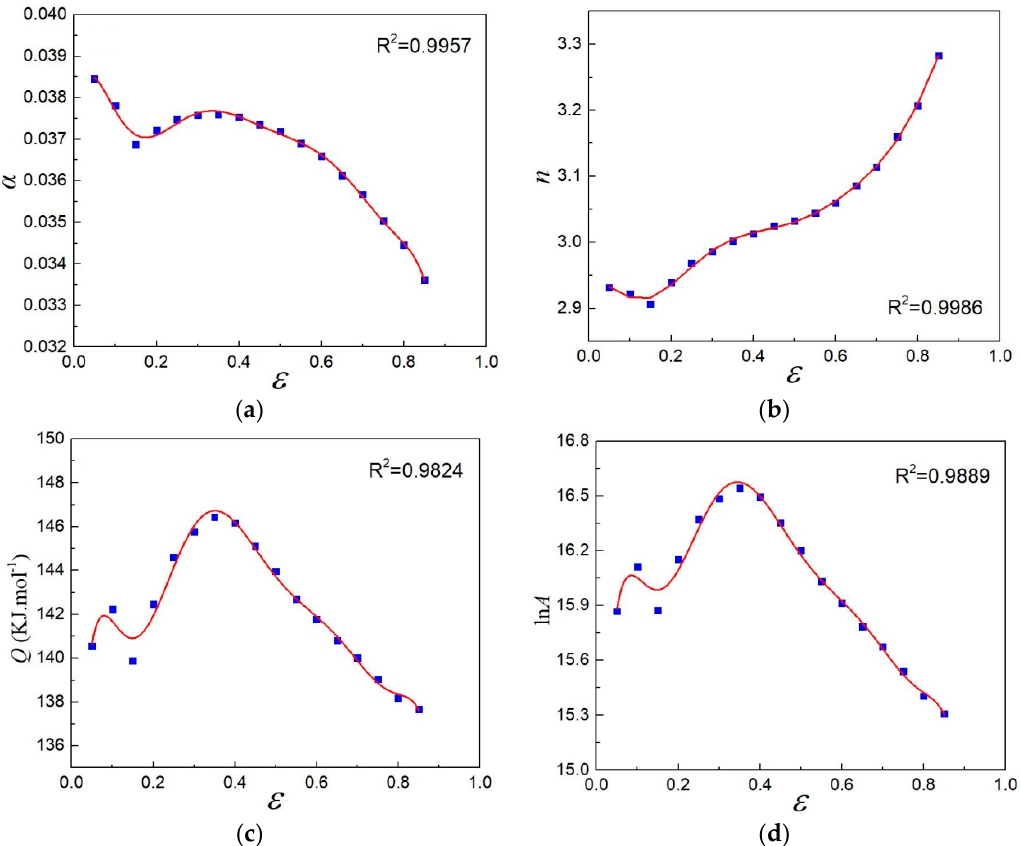
Figure 4. Eighth-order polynomial regression results between true strain and ( a ) α , ( b ) n , ( c ) Q , ( d ) ln A